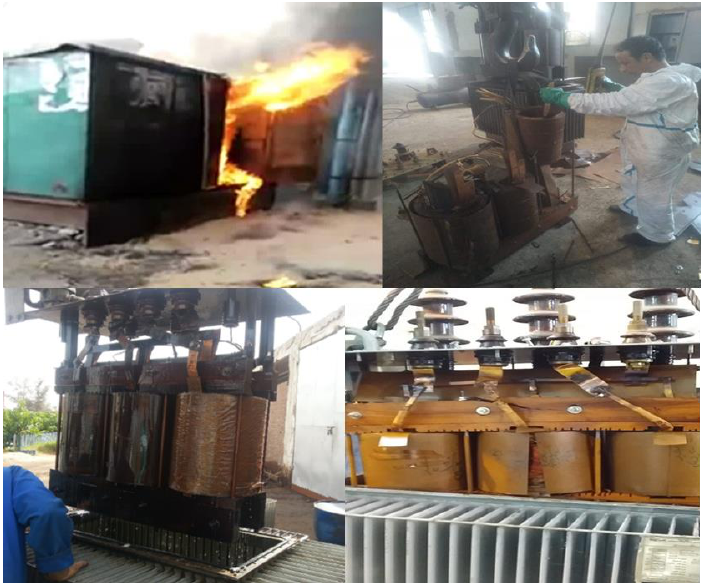
Figure 2. Process of inspecting the insulation system inside DT.